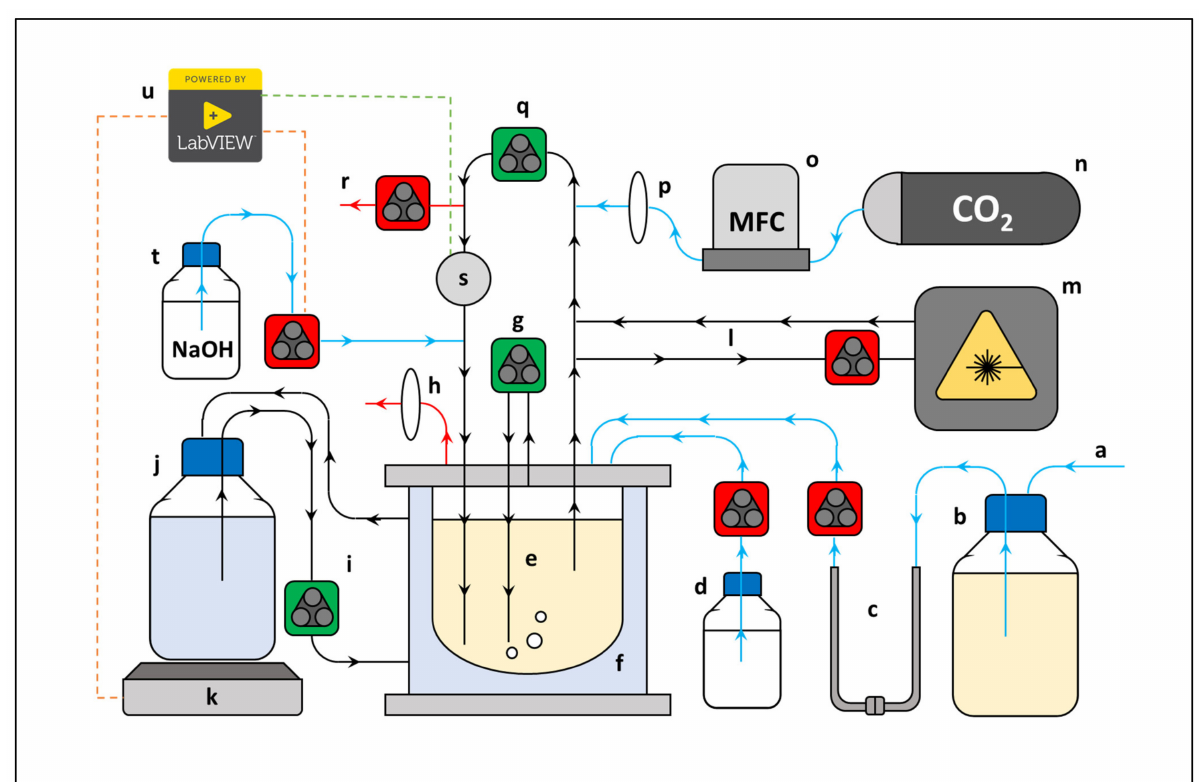
Figure 6. Simplified scheme of reactor setup. ( a ) multiple sterile inlet lines, ( b ) media reservoir, ( c ) detachable U-connection (sterilised in oil bath), ( d ) antifoam reservoir, ( e ) reactor vessel, ( f ) water jacket, ( g ) gas recycle line, ( h ) gas outlet, ( i ) heat transfer recycle line, ( j ) heated water reservoir, ( k ) hotplate, ( l ) spectrophotometer recycle line, ( m ) flow cell spectropho- tometer, ( n ) CO 2 gas tank, ( o ) mass flow controller, ( p ) air filter, ( q ) liquid recycle line, ( r ) sample line, ( s ) temperature/pH probe, ( t ) NaOH reservoir, ( u ) LabVIEW™ operated temperature/pH controller coupled to input ( s ), green stippled line) to subsequently regulate the outputs ( t , k , red stippled lines). Pumps: high velocity (green), low velocity (red). Recycle lines (black), inlet lines (blue), outlet lines